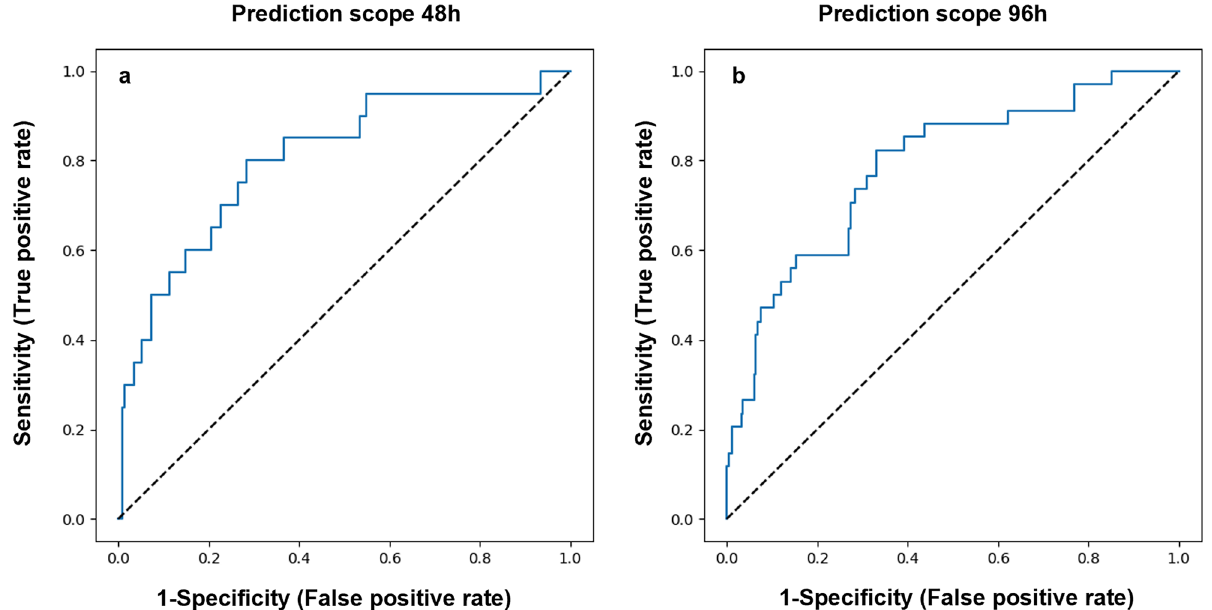
Figure 3. Internal validation results. Model accuracy, measured on the internal validation dataset from Sheba Medical Center, as shown in ROC curves, for prediction scopes of ( a ) 48 h and ( b ) 96